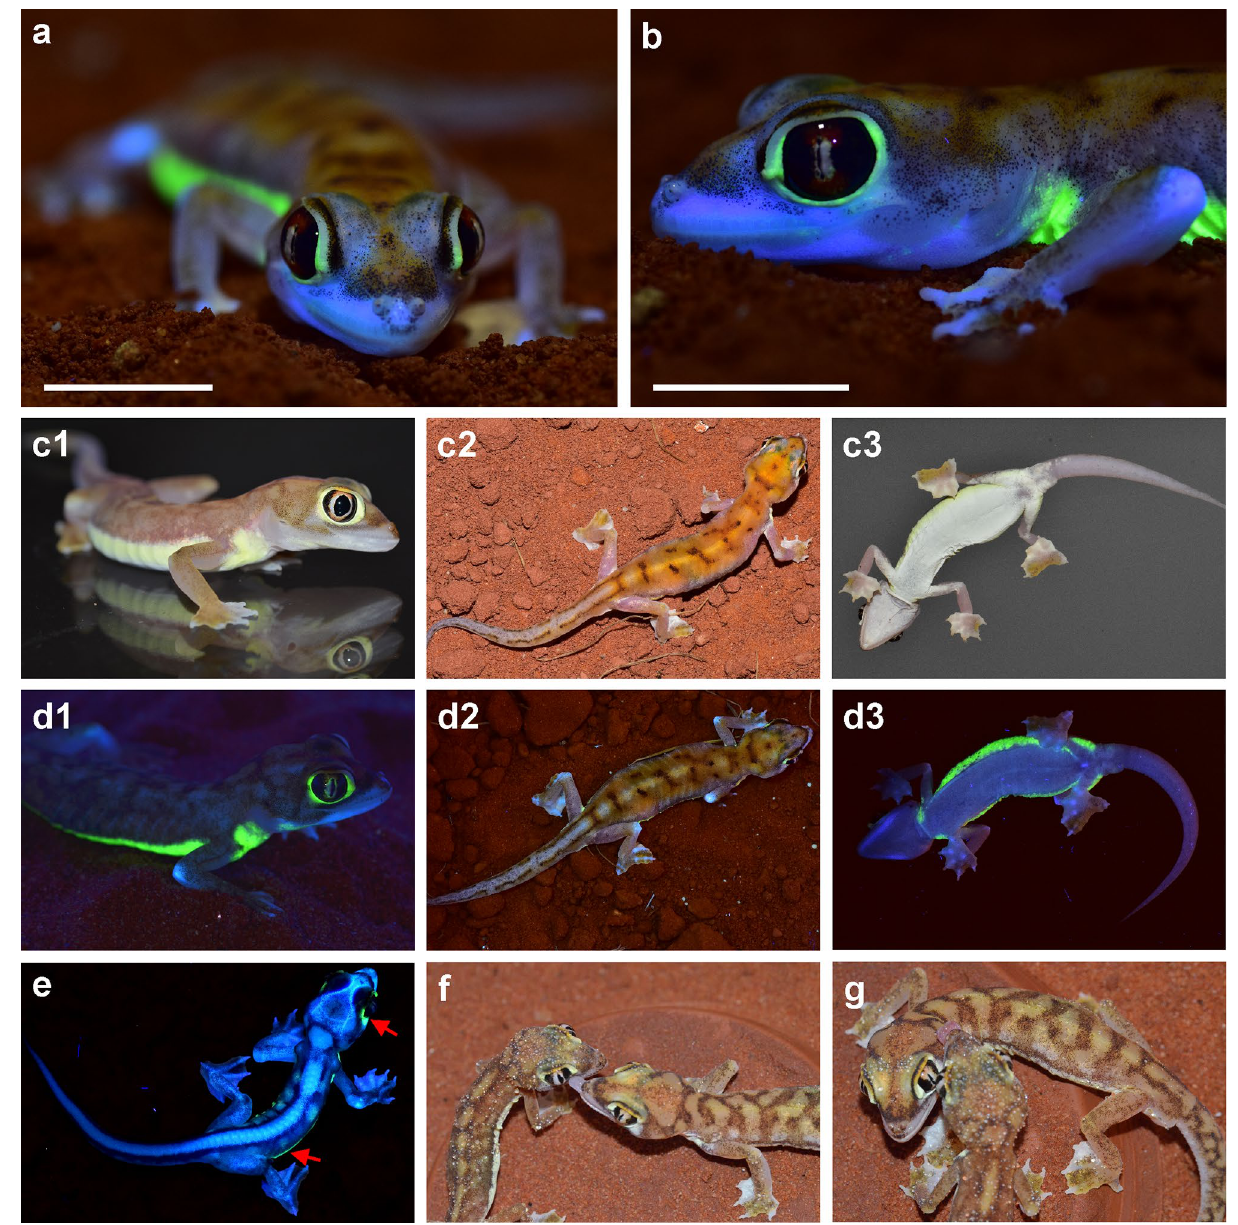
Figure 1. Pachydactylus rangei under UV illumination and under visible light. ( a , b ) Female P. rangei under UV illumination at 365 nm and (visible) dim background illumination; scale bars = 10 mm. ( c ) P. rangei under visible light in lateral ( c1 , male), dorsal ( c2 , female), and ventral view ( c3 , female). ( d ) The respective specimens illuminated with UV light (maximum emission at 365 nm) and dim background illumination in lateral view ( d1 , male), dorsal ( d2 , female) and ventral view ( d3 , female) showing neon-green fluorescence around the eyes and along a ventrolateral stripe. Note that the 365 nm light used to produce this fluorescence is far from the 465 nm peak excitation wavelength. ( e ) Hatchling, nine days post hatching, showing both the green dermal fluorescence seen in adults (indicated by red arrows) as well as blue bone fluorescence at the vertebrae, skull and the phalanges through its translucent skin. ( f , g ) P. rangei approaching each other and licking water from each other’s bodies (husbandry